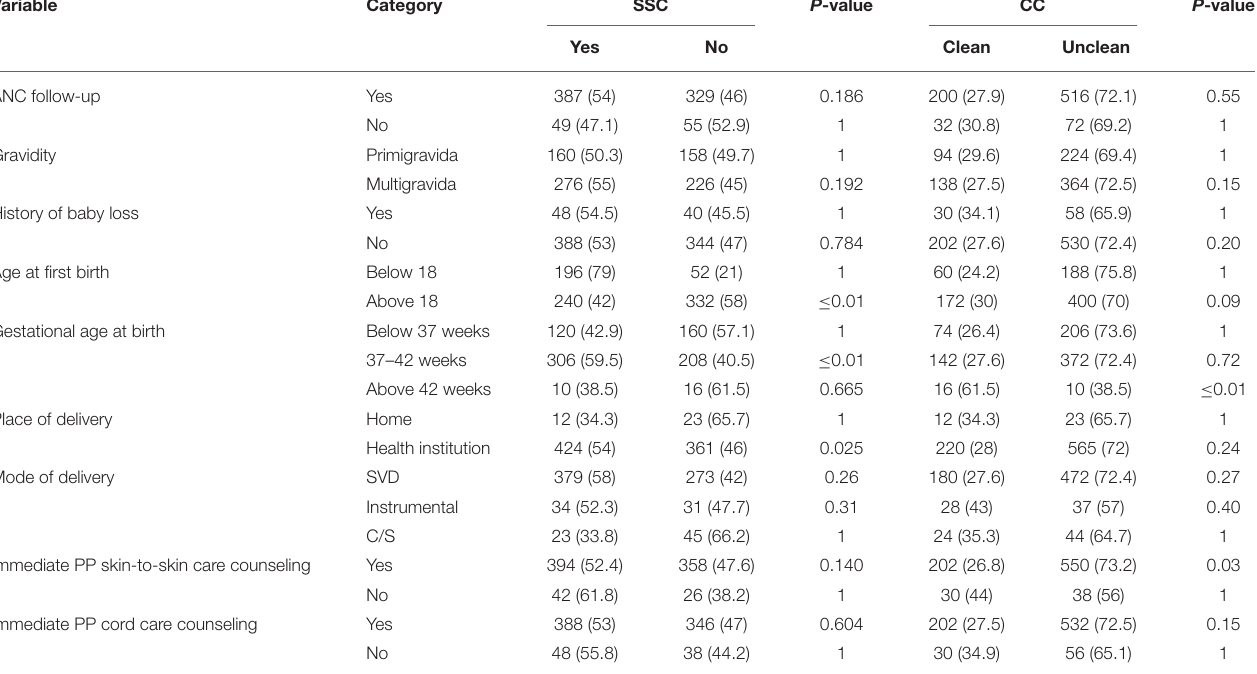
TABLE 2 | Health service utilization among post-partum women at public hospitals of Eastern Ethiopia, 2021.